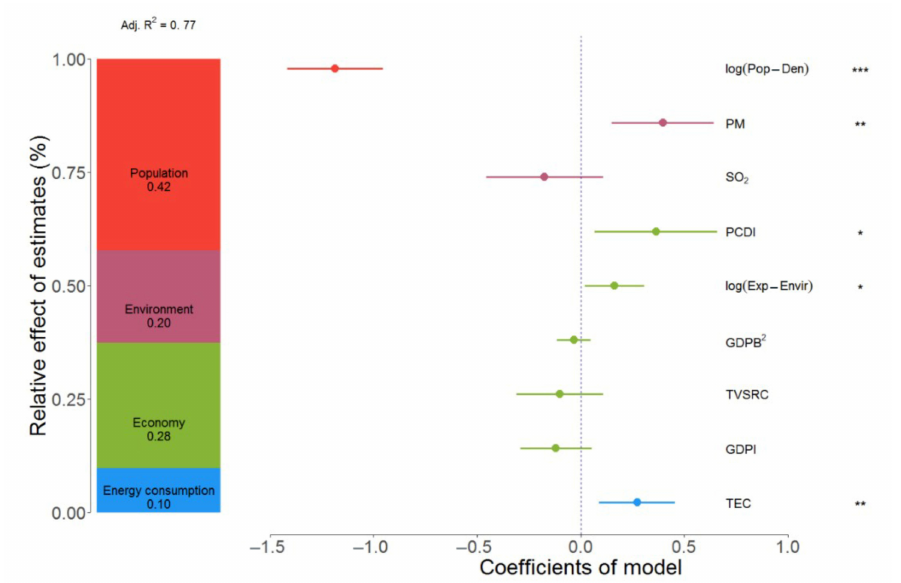
Figure 4. Coefficients and relative effects of parameters of the multiple regression model (N = 96). Left subgraph: relative importance of parameters and adjusted R 2 of the model. Right subgraph: average model coefficients based on the selection of AICc and max VIF. Mean coefficients and their 95% confidence interval are shown by points and error bars. The marks of significance are: ***: p < 0.001, **: p < 0.01, *: p < 0.05. Abbreviations: environmental factors: sulfur dioxide concentration (SO 2 ), fine particulate matter concentration (PM); economic factors: industrial production value (GDP-I), GDP of construction, total retail sales of consumer goods (TVSRC), and per capita disposable income (PCDI); environmental protection expenditure (log(Exp-Env), log-transformed); energy consumption factor: total energy consumption (TEC); population factor: population density